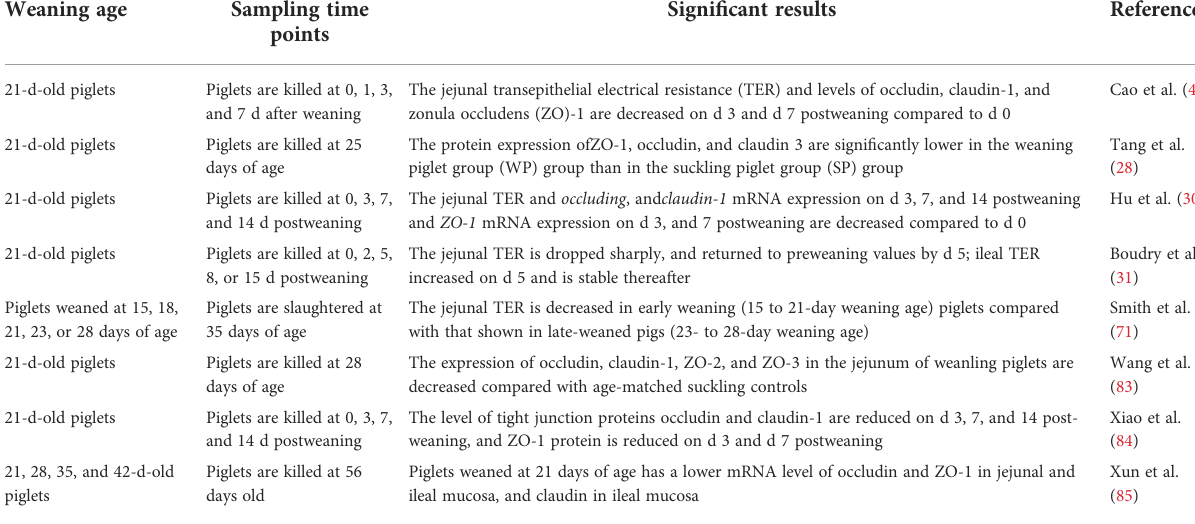
TABLE 1 A summary of the effects of weaning stress on intestinal mechanical barrier function in piglets. Weaning